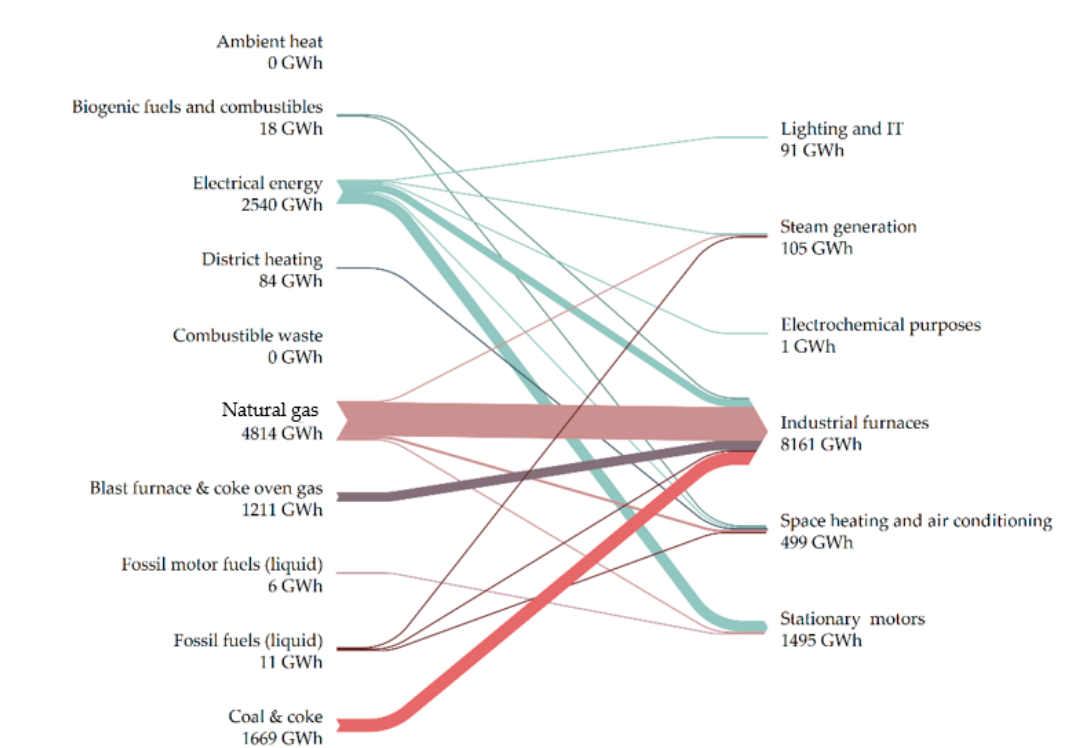
Figure 2. Exemplary energy flow chart of the iron and steel sector in Austria in 2019 based on the used energy carriers (left) and the six useful energy categories (right) where fossil fuels are in reddish colors and renewables in greenish colors (data based on [5]).